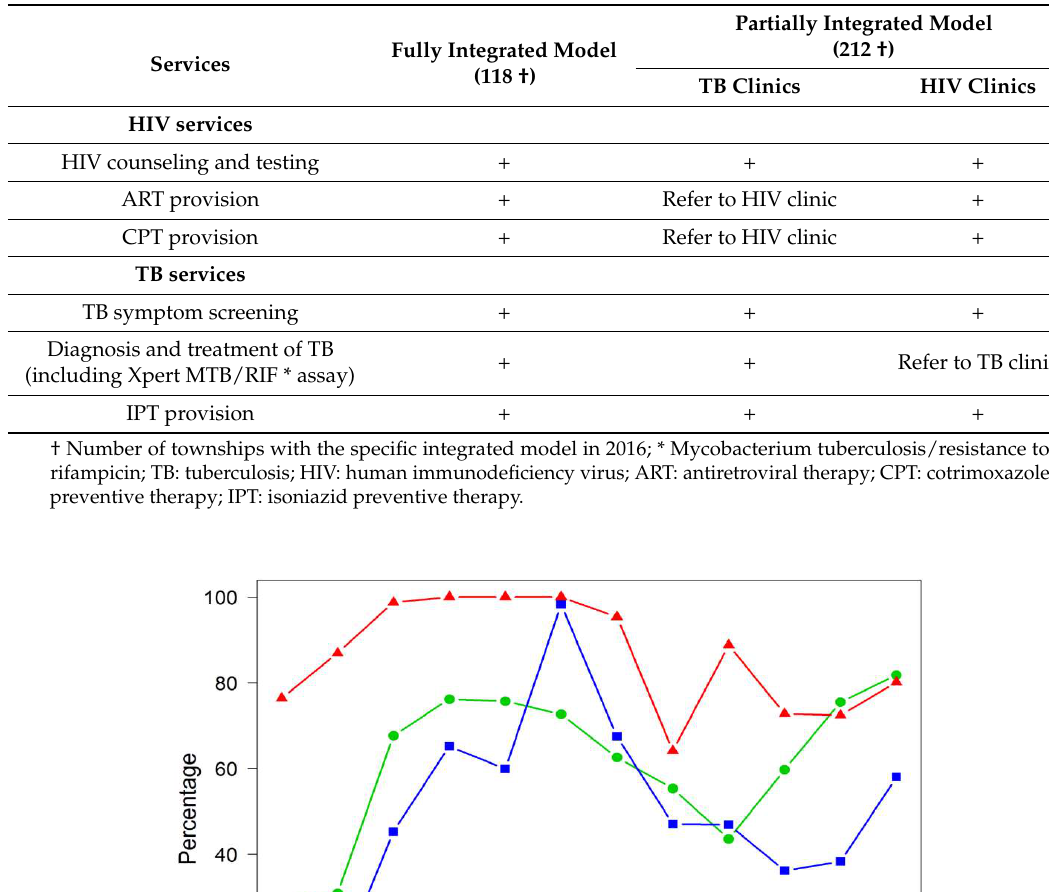
Table 2. Availability of Services for TB/HIV co-infected patients.